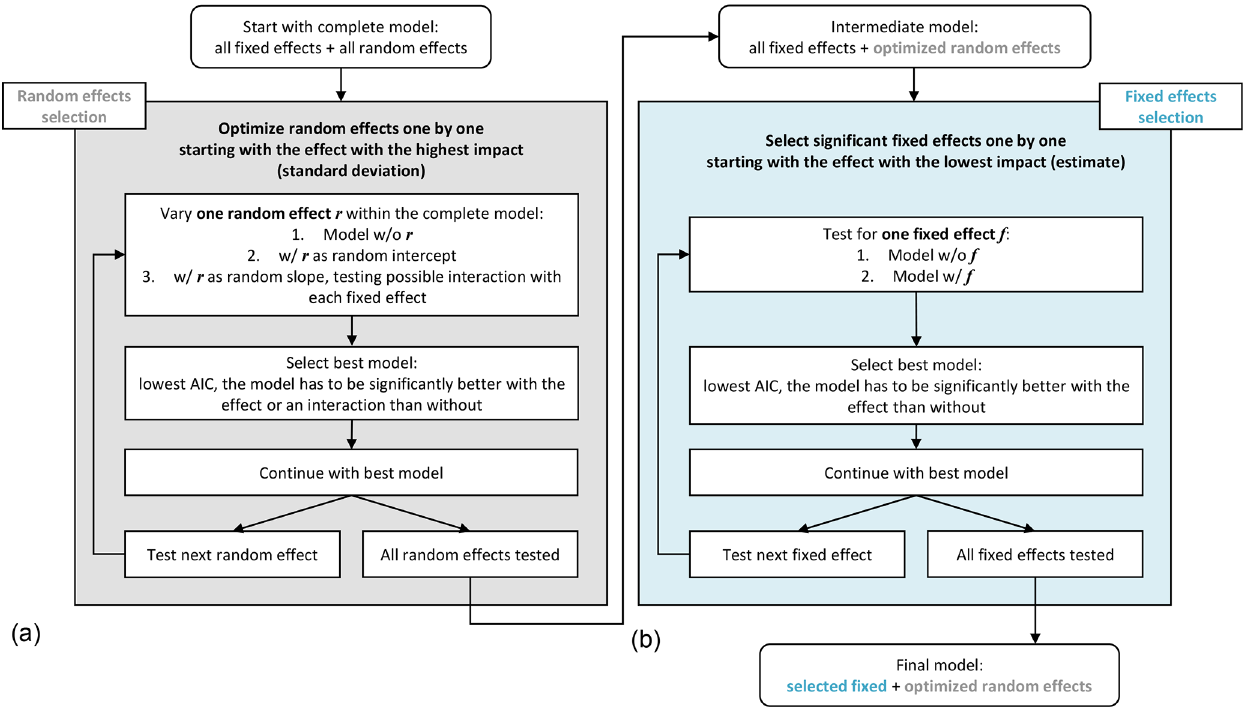
Figure 2. Workflow of the linear mixed effects models development steps, consisting of (a) the optimization of the random effects and (b) the selection of significant fixed effects. “w/o” refers to without and “w/” refers to